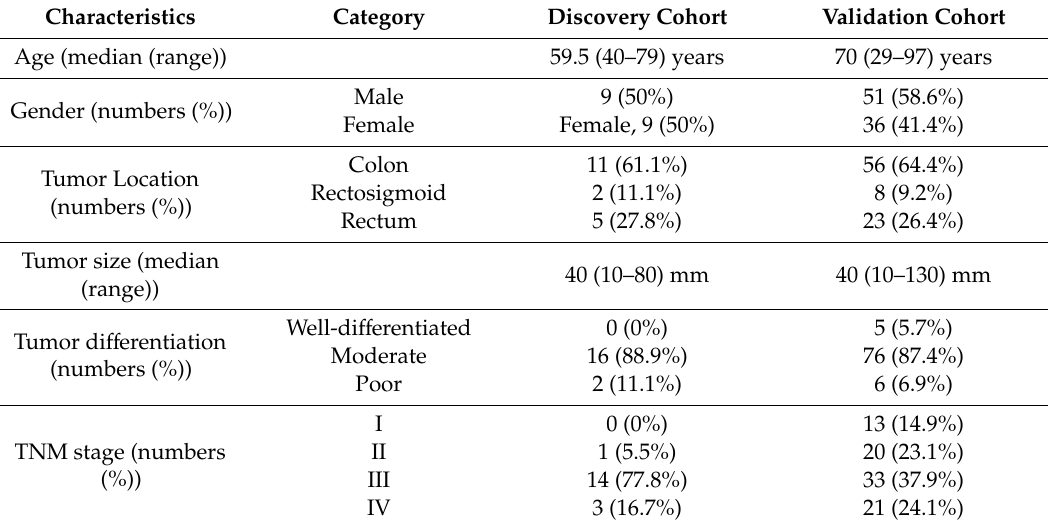
Table 1. Characteristics of patients in the discovery and validation cohorts.